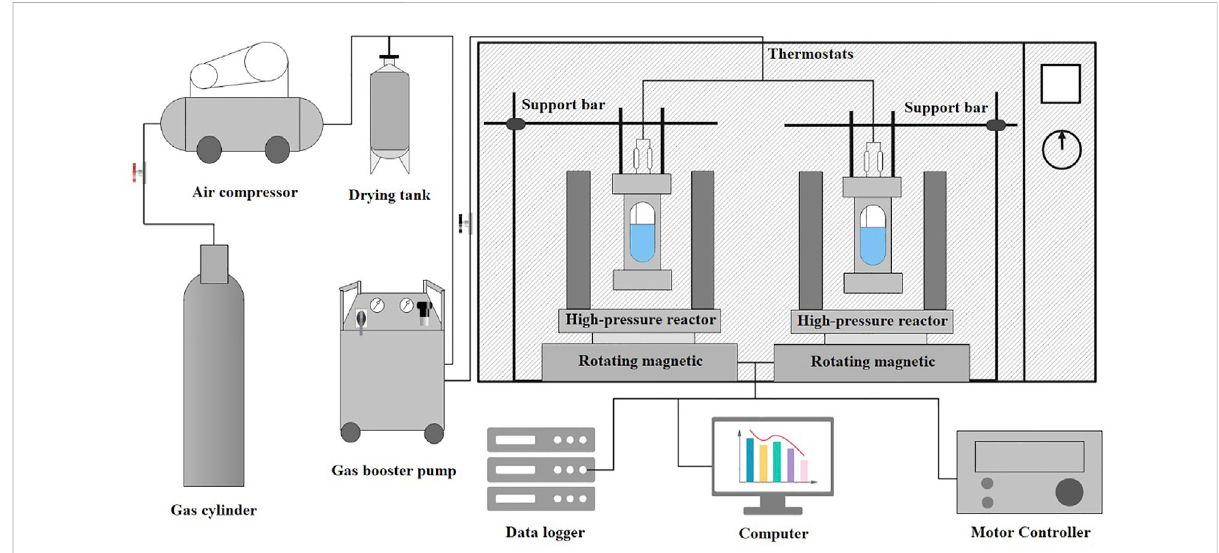
FIGURE 1 Schematic diagram of the experimental device for rapid hydrate formation under a magnetic fi